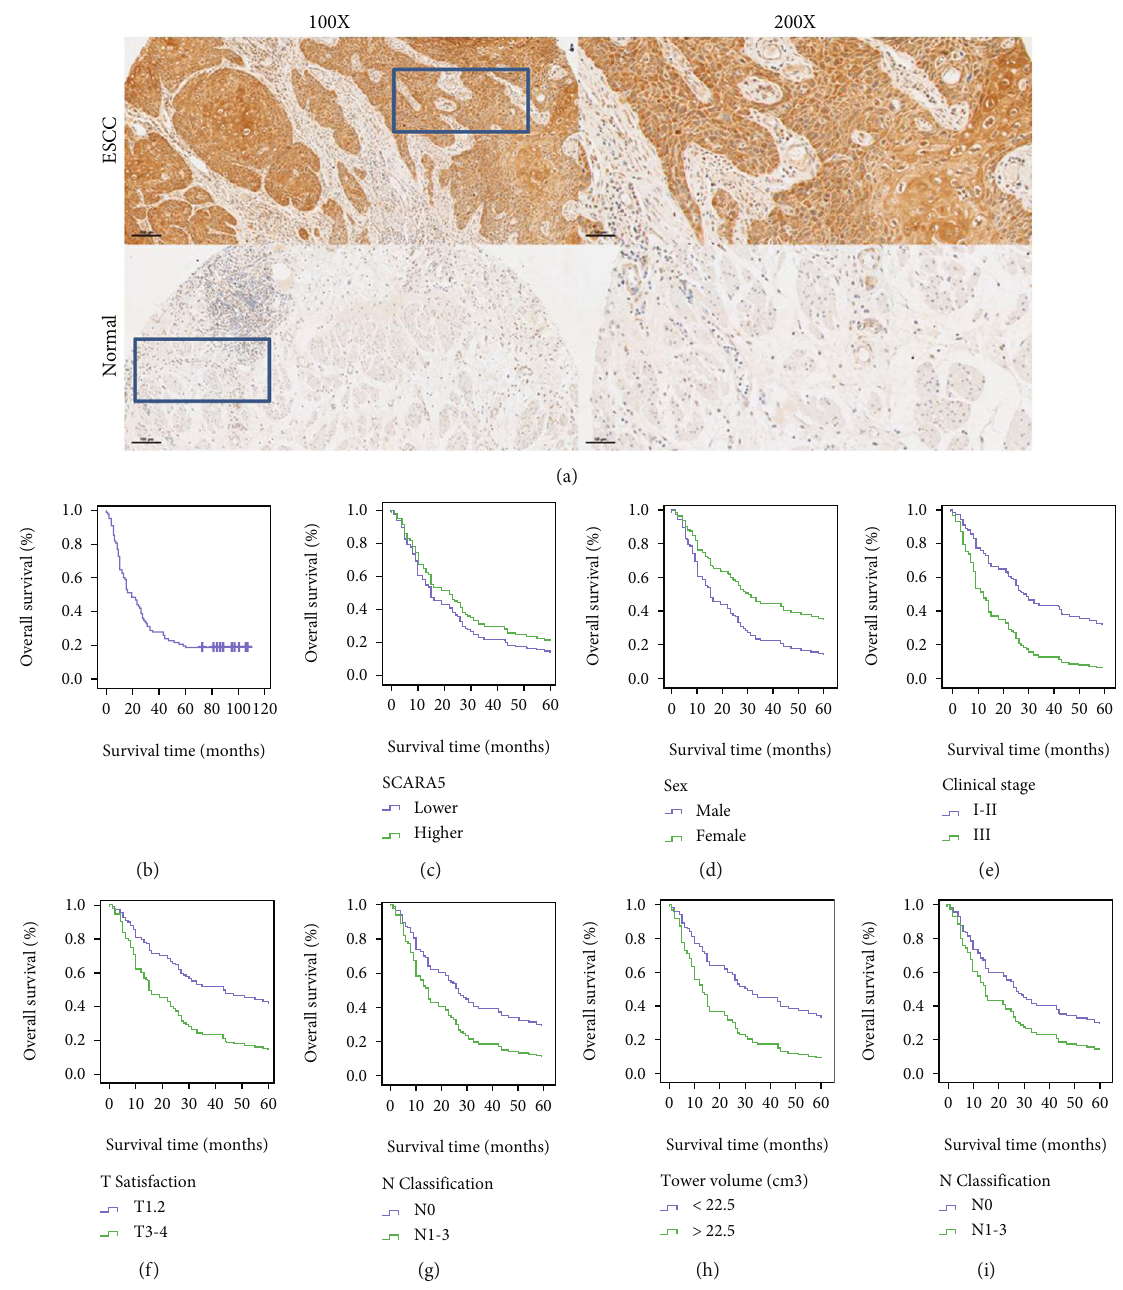
Figure 4: Detection of SCARA5 expression in ESCC and paired normal tissues and its prognostic signi fi cance. (a) Expression of SCARA5 in ESCC and paired normal tissues was detected using IHC. (b) K-M survival curve for all the patients. (c) SCARA5 expression was related to the prognoses. (d – h) Sex, clinical stage, T classi fi cation, N classi fi cation, tumor volume, and longest diameter of the tumor were related to the prognoses according to the univariate prognostic